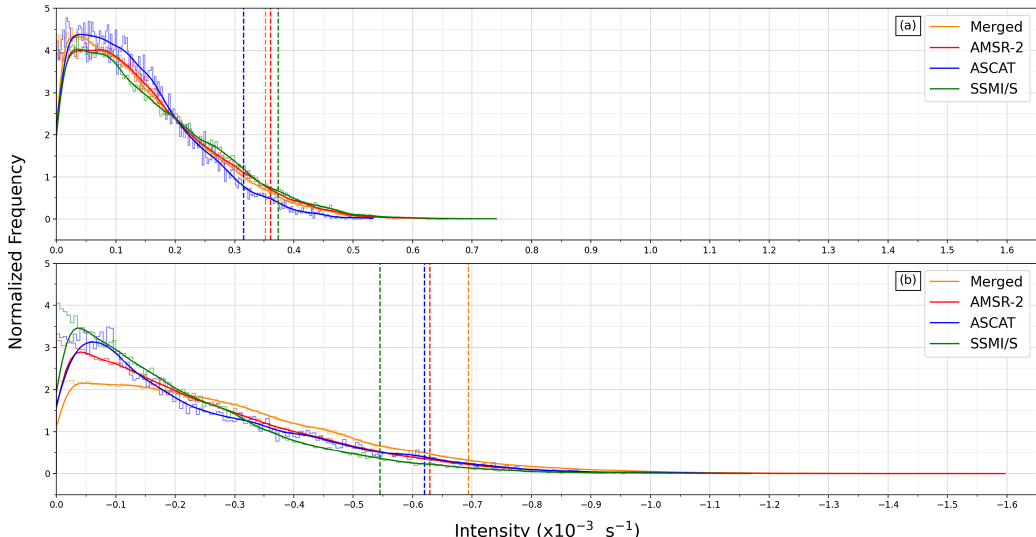
Figure 5. The normalized frequency distribution of (a) anticyclonic vorticity features and (b) cyclonic vorticity features from 2016–2020 (note the reverted x axis for comparison). Lighter shaded lines show a stepped histogram of 200 bins, while the darker shaded curve represents a kernel-density estimate using Gaussian kernels. Vertical dashed lines indicate the intensity threshold of the 95th